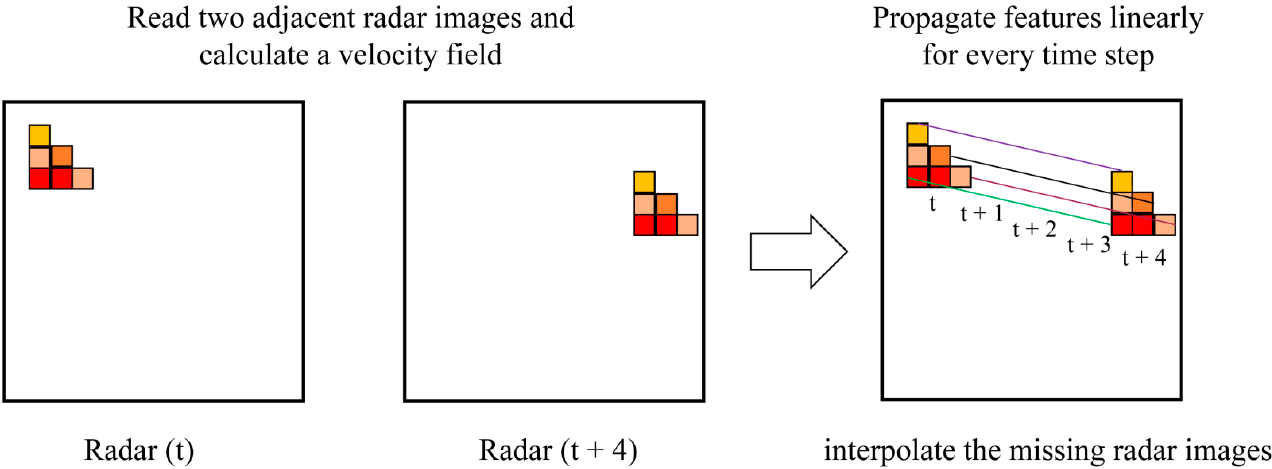
Figure 2. Schematic diagram of interpolating three radar frames from two adjacent radar images using optical flow model.